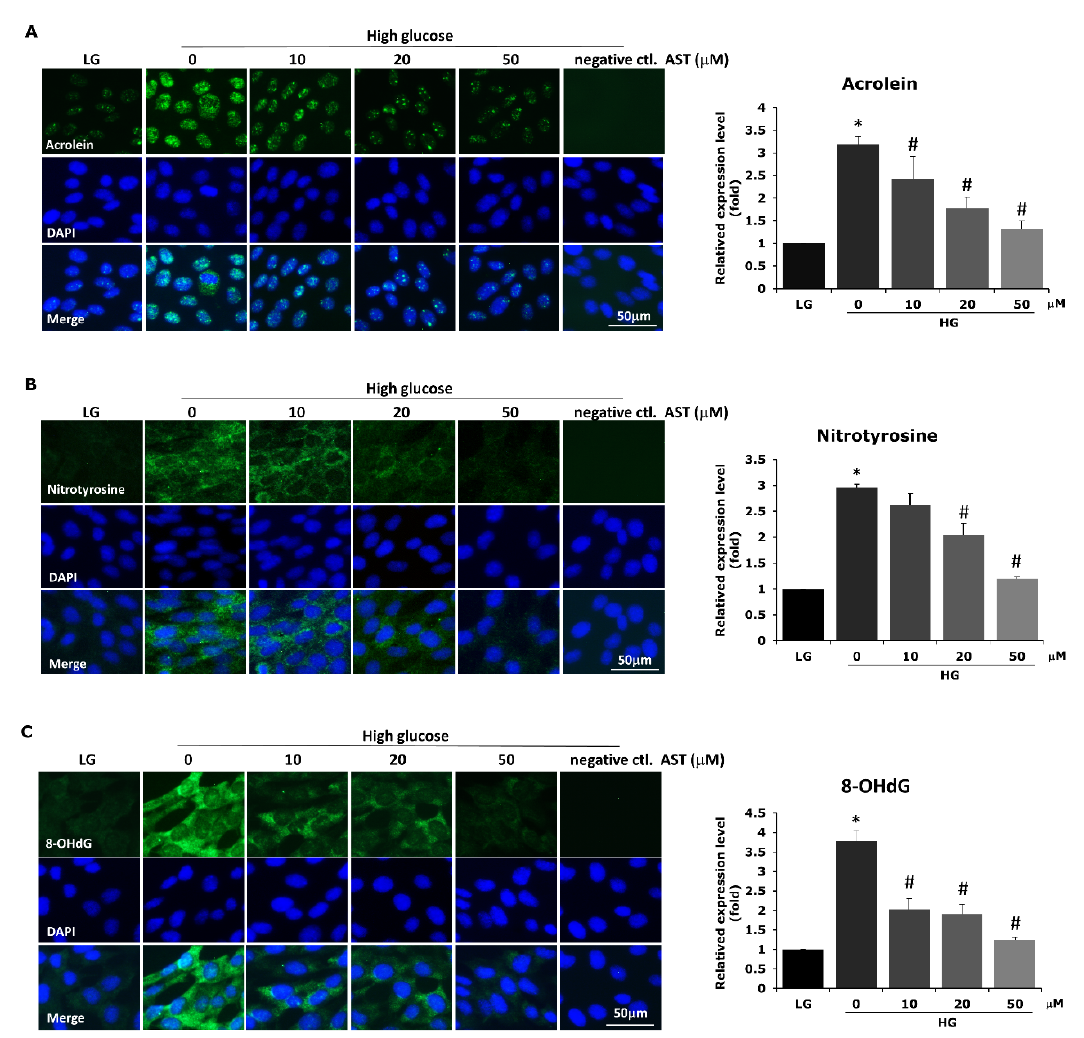
Figure 3. AST reduces ROS-related lipid, protein, and DNA damage in high glucose-treated 661W cells. To confirm that high glucose-induced ROS-related damage was also attenuated by AST treatment, we measured the expression of acrolein ( A ), nitrotyrosine ( B ), and 8-OHdG ( C ) by immunocytochemistry to indicate the oxidative damages to lipids, proteins, and DNA, respectively. Significantly decreased oxidative damage was noted under AST treatment. AST = astaxanthin; HG = high glucose; LG = low glucose; ROS = reactive oxygen species. * Significantly di ff erent from control group ( p < 0.05); # significantly di ff erent from high glucose-treated group without AST ( p < 0.05). The Mann–Whitney U test was used to calculate the di ff erences between the means of di ff erent experimental groups (three repeats per experiment, three wells per repeat, five images per well analyzed).